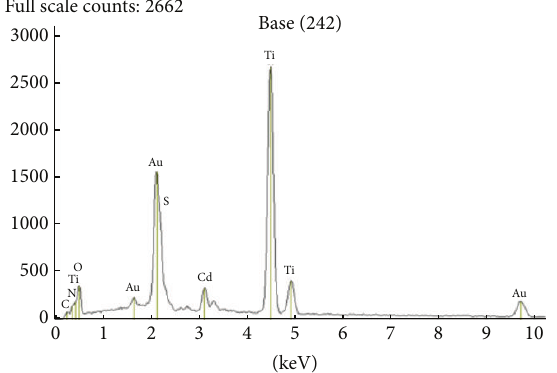
Figure 5: Representative EDX spectrum of TCd4 nanocomposite.